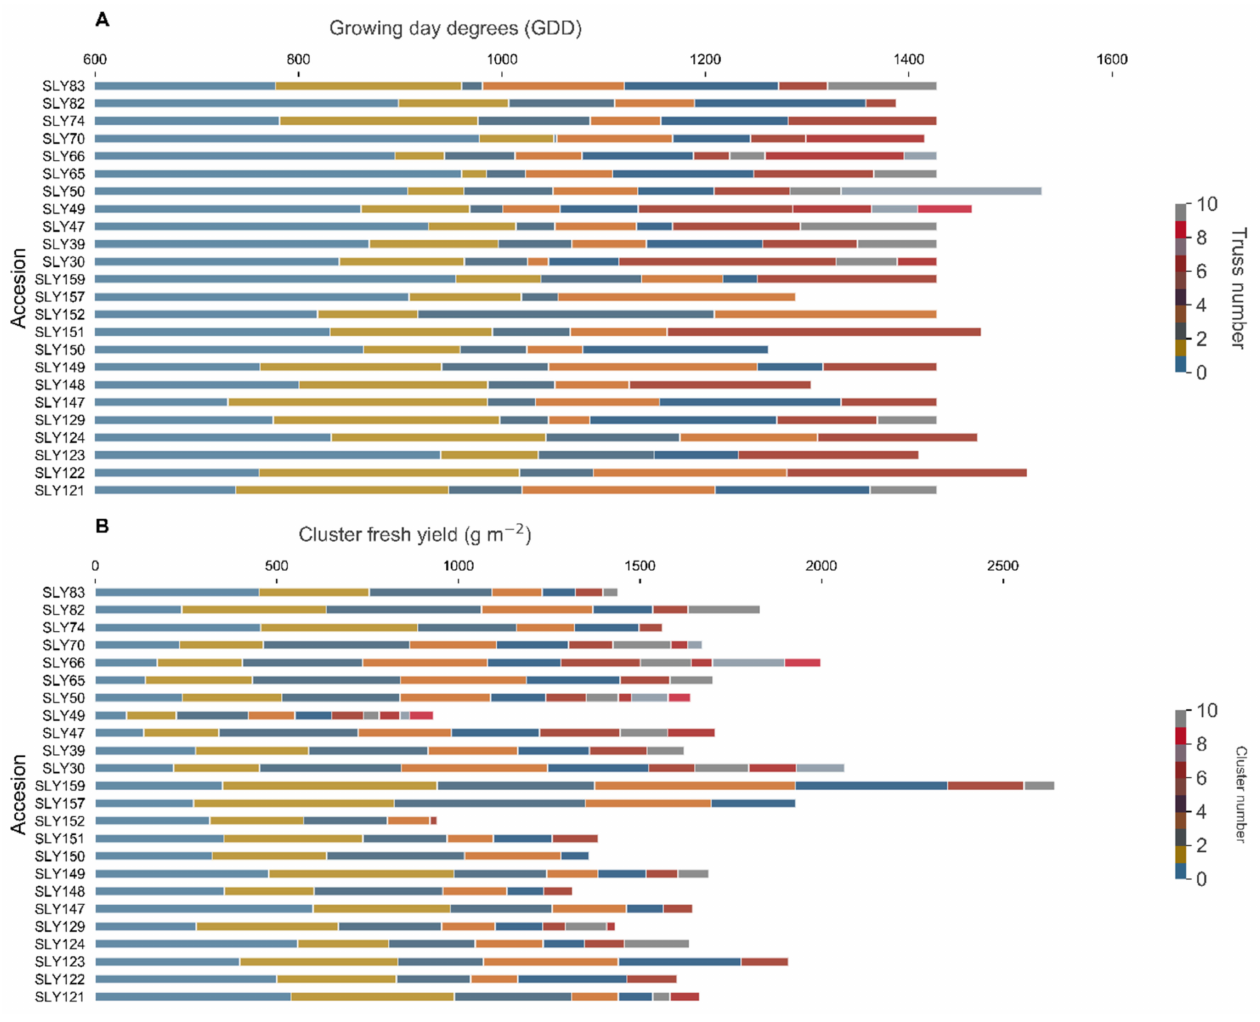
Figure 3. Yield patterns of tomato landraces grown in Santiago during the 2016–2017 season. ( A ): Accumulated growing degree days (GDD) between the harvest of each cluster, ( B ): Yield by cluster. The color in each bar represents the number of clusters. Each color bar is the average for each cluster per accession; color bars not seen are due to the population average being equal to, or lower than, the average of the consecutive